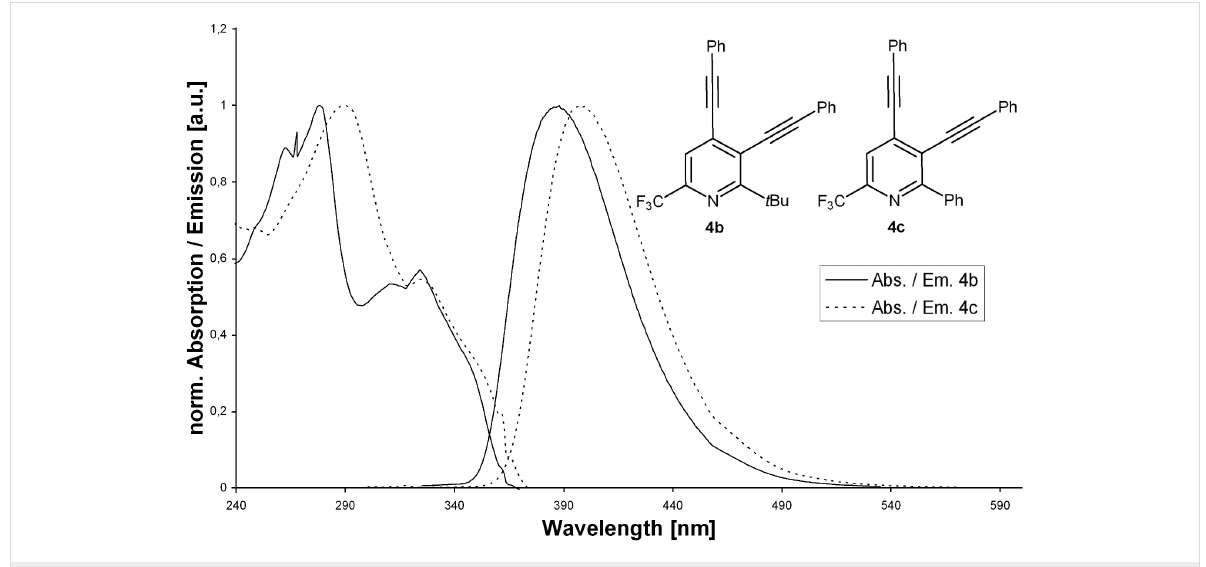
Figure 2: Absorption and fluorescence spectra of compounds 4b and 4c .